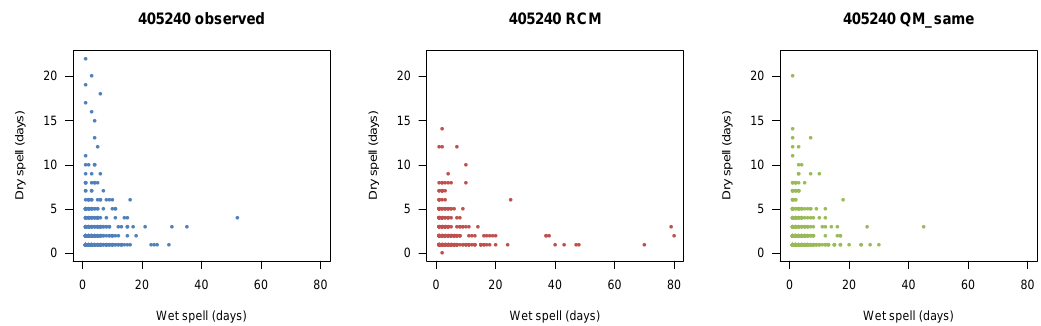
Figure 13. Scatter plots showing the length of each dry spell on y axes and the length of the following wet spell on x axes for observed, raw RCM and QM bias-corrected RCM precipitation for an example